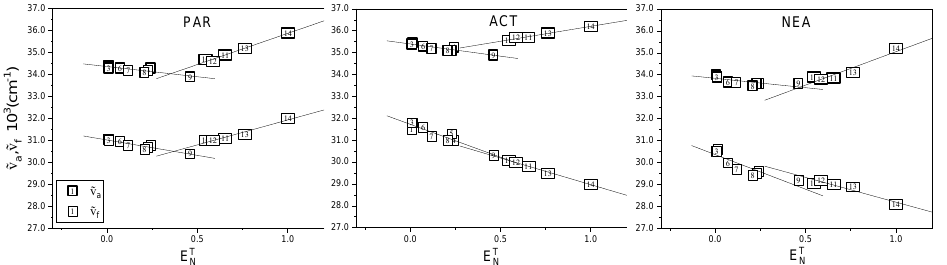
Figure 3. Positions of the long-wavelength absorption ( ˜ ν a ) and fluorescence ( ˜ ν f ) bands as a function of E T N